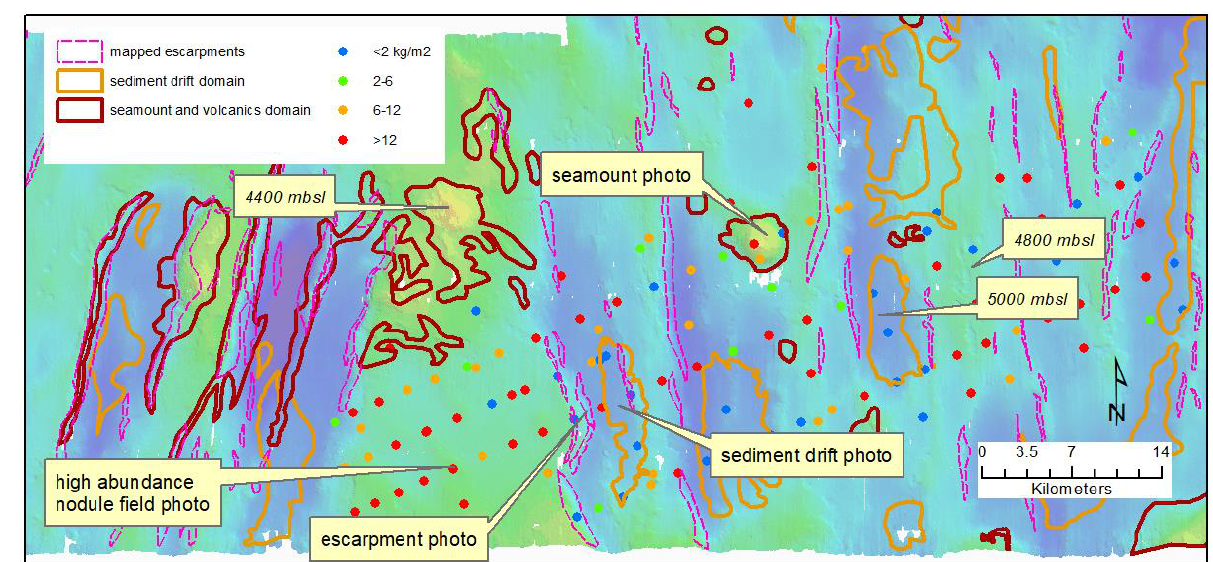
Figure 8. Nodule-rich and nodule-poor areas on a typical area of seafloor in the CCZ. The scheme shows 12-kz multibeam echosounder (MBES) backscatter based on bathymetry and sample data. For scale, the sample symbols are typically 3-km apart (refer also to Figure 9). Abundance (coloured) is given in wet kg/m 2 ; the acoustic absorption (backscatter; grey scale) is in dB. Very dark areas generally relate to exposed volcanics (no nodules to speak of and not sampled), very light areas generally relate to sediment drifts (some sampled), and intermediate grey areas are nodule-bearing sediments. Within the white outline is the area that was estimated to an indicated and measured level of confidence, while outside, it was esti- mated to an inferred level.